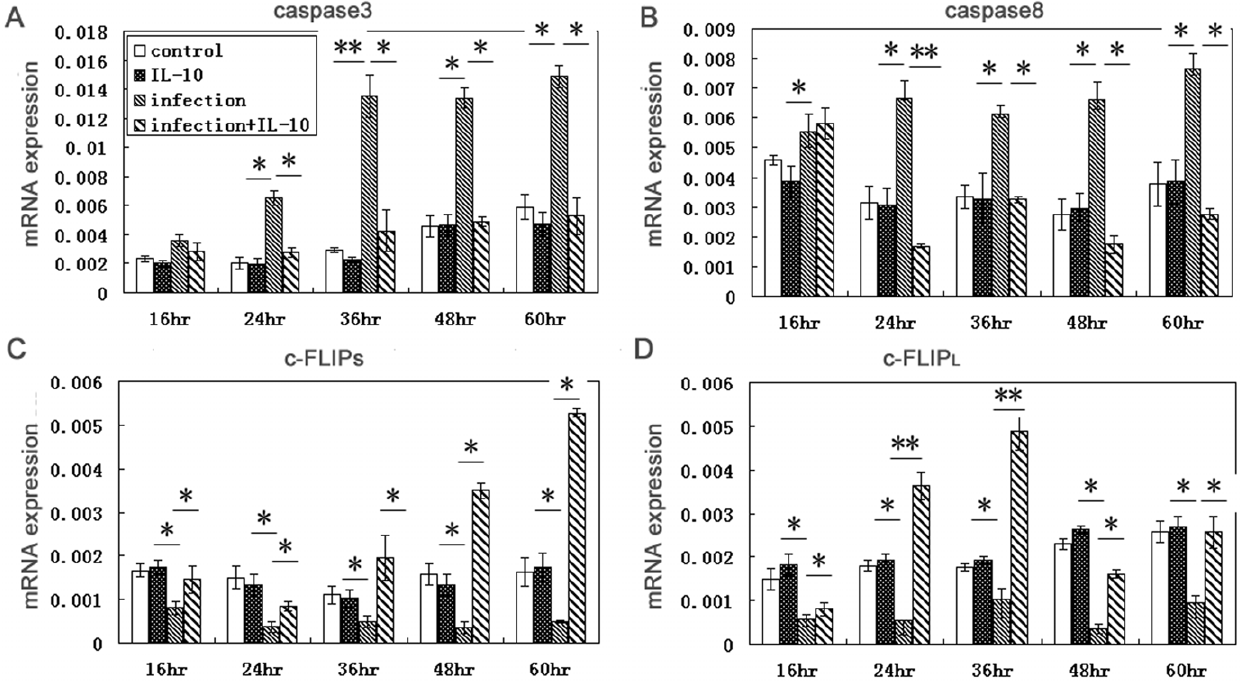
Figure 6. Changes in expressions of mRNAs encoding caspase-3, caspase-8, c-FLIP L and c-FLIP S in primary human trophoblast cells result from infection are reverted upon IL-10 treatment. Caspase-3 (A) and caspase-8 (B) were both increased while c-FLIP S (C) and c-FLIP L (D) were decreased in infected cells relative to uninfected cells. Levels were reduced in infected cells treated with IL-10 compared to infected cells while no changes in treatment IL-10 in untreated cells relative to uninfected cells. * p , 0.05; ** p , 0.01.